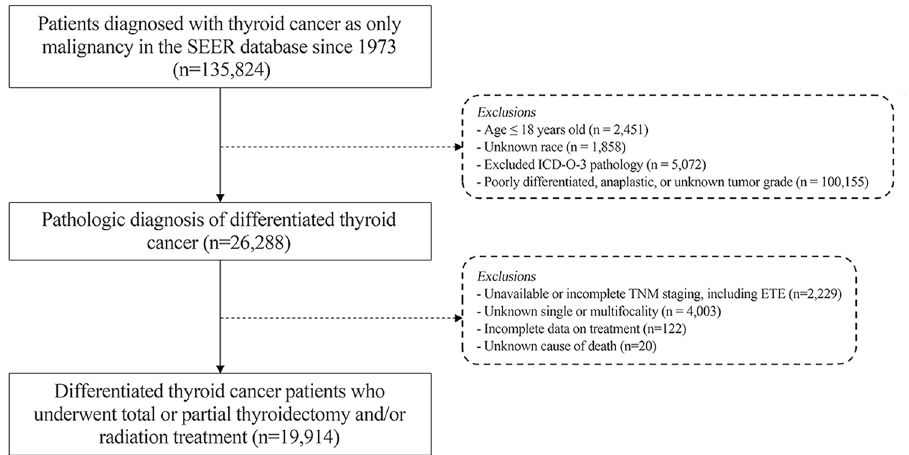
Figure 3. Flow diagram of the SEER database search. Flow diagram of the SEER database with inclusion and exclusion